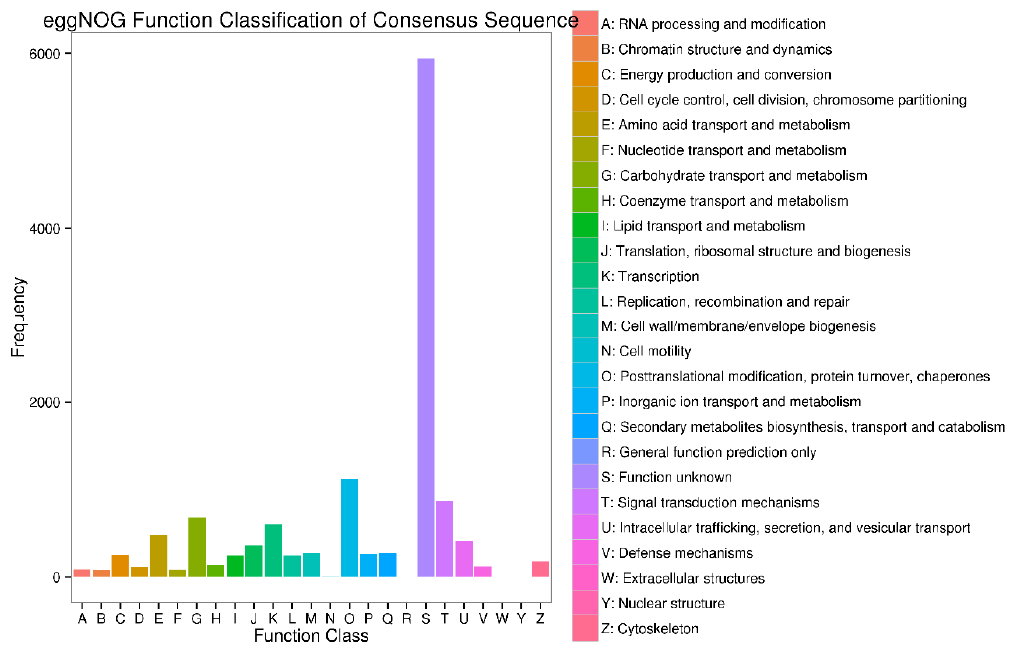
Figure A3. EggNOG function classification of the annotated DEGs between the two individuals numbered S05 and S11. The horizontal axis represents the EggNOG categories and horizontal axis represents the gene number.